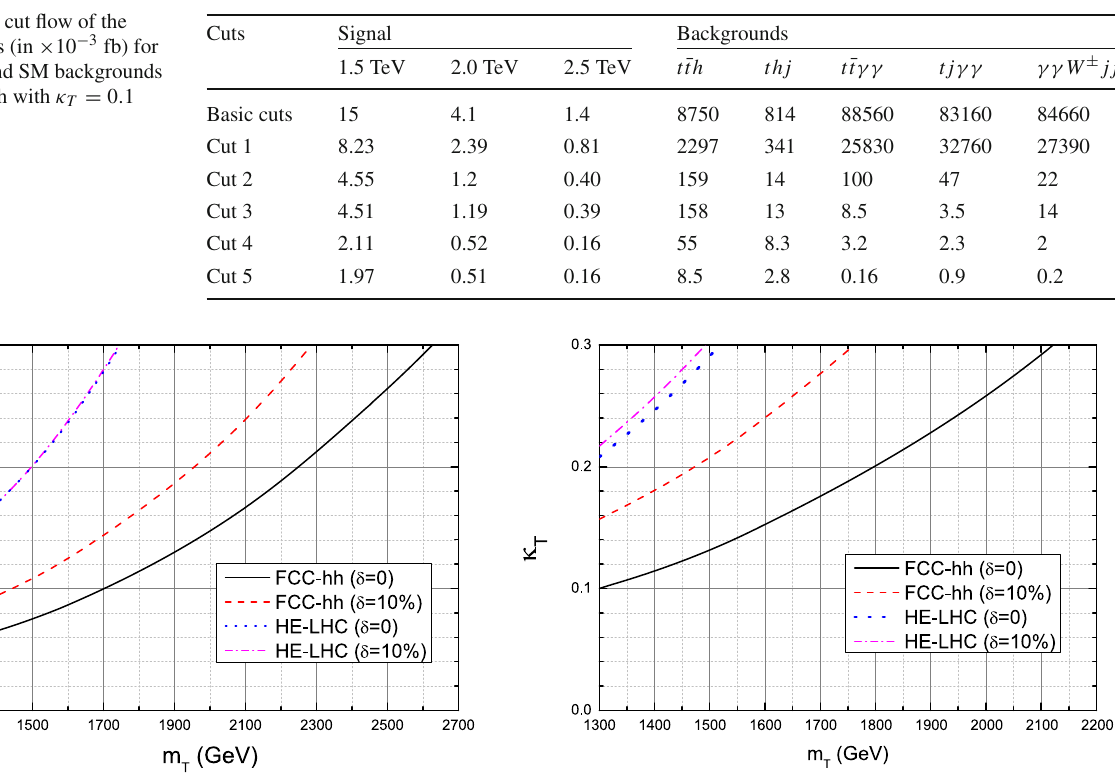
Fig. 4 The exclusion limit (at 95% CL) (left) and discovery prospects (at 5 σ ) (right) contour plots for the signal in κ T − m T planes at HE-LHC with integral luminosity 15 ab − 1 and at the FCC-hh with integral luminosity 30 ab −